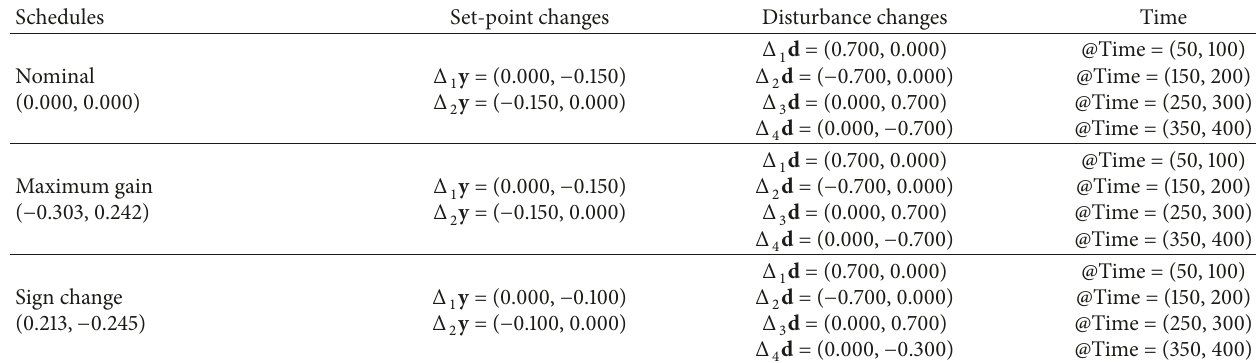
Table 3: Programmed plant tests for Case 2